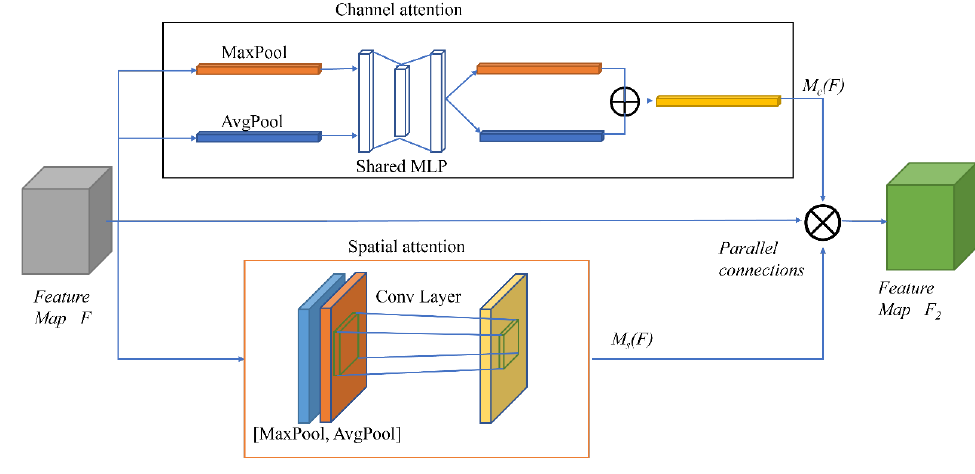
Figure 5. The overall structure of I_CBAM.